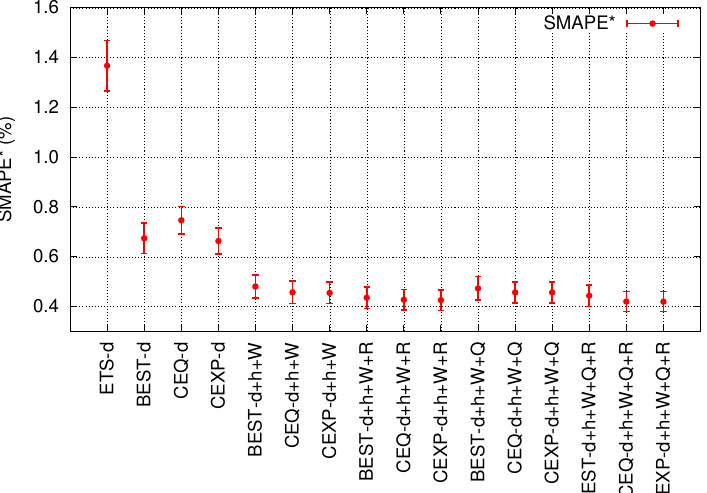
Figure 7. SMAPE (cid:63) error plot with the 99% confidence interval for the models of Table 5 in the test